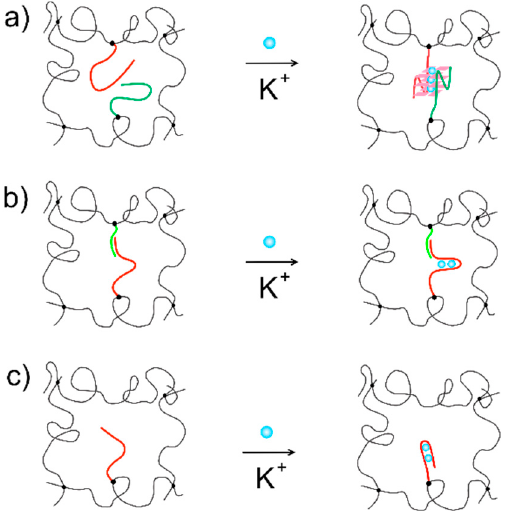
Figure 1. Schematic illustration of potassium aptamer sequence structures and their integration in hydrogels for label-free biosensing. ( a ) Oligo-3; ( b ) KLM-L; ( c ) KLMss. In the initial experiments, we compared potassium-induced changes of the optical length of the hydrogels with the various aptamer oligonucleotide sequences. The potas- centrations up to 7 mM in an aqueous solution of 0.1 M phosphate buffer (note that this buffer condition implies a sodium concentration of 0.177 M originating from the phos-